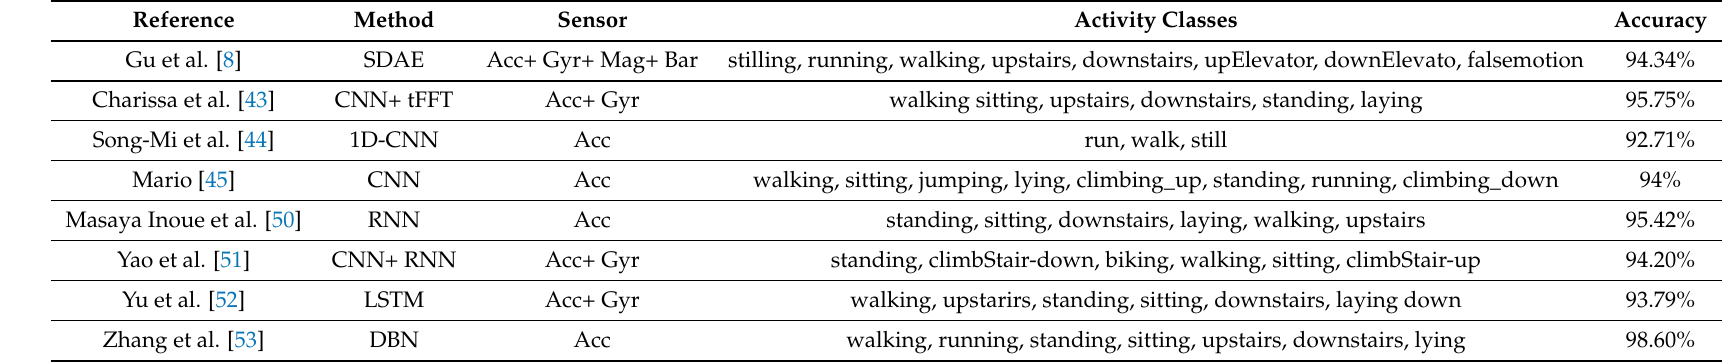
Table 1. References of applying deep learning methods on activity recognition (the Acc is accelerometer, the Gyr is gyroscope, the Mag is magnetometer, and the Bar is